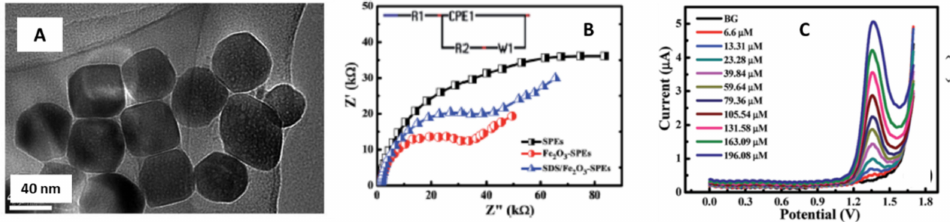
Figure 13. ( A ) Fe 2 O 3 nanocubes HR-TEM micrograph. ( B ) Nyquist plots obtained for the non- modified SPEs, Fe 2 O 3 -NCs-SPEs and SDS/Fe 2 O 3 -NCs-SPEs. ( C ) Differential pulse